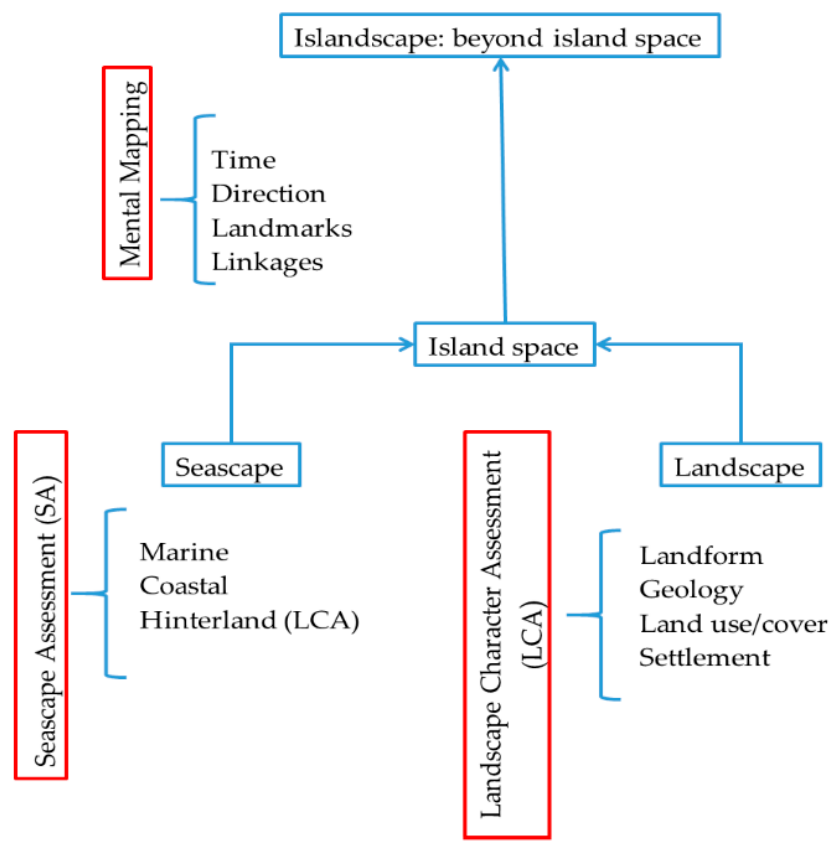
Figure 2. A conceptual framework for islandscapes mapping. Red boxes correspond to existing methodologies/techniques which could be employed to map the respective